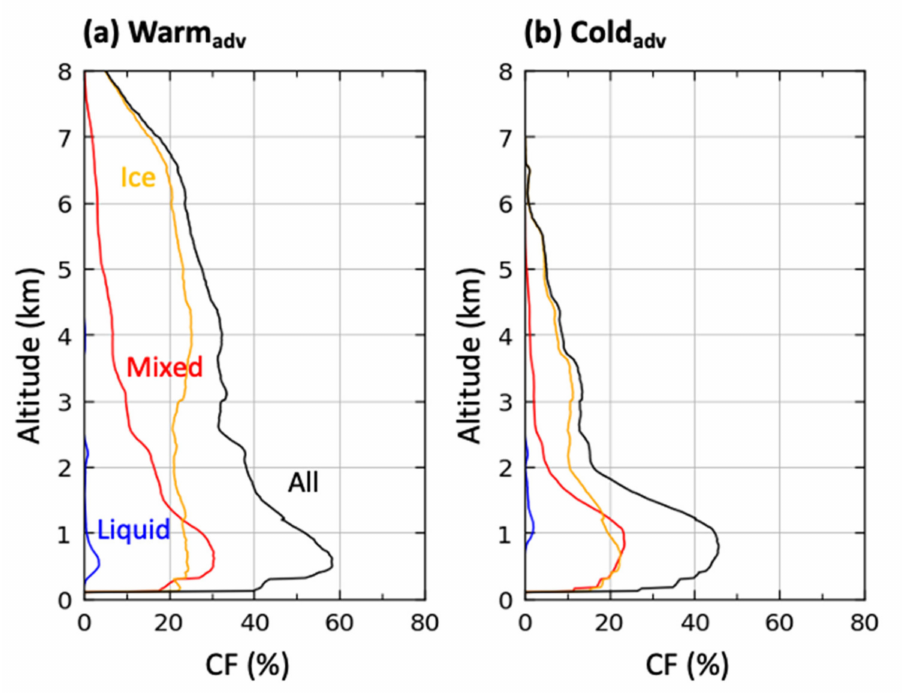
Figure 5. Vertical distributions of CF for different cloud phases (all: black, liquid: blue, ice: yellow, mixed-phase clouds: red) during ( a ) warm adv and ( b ) cold adv cases.